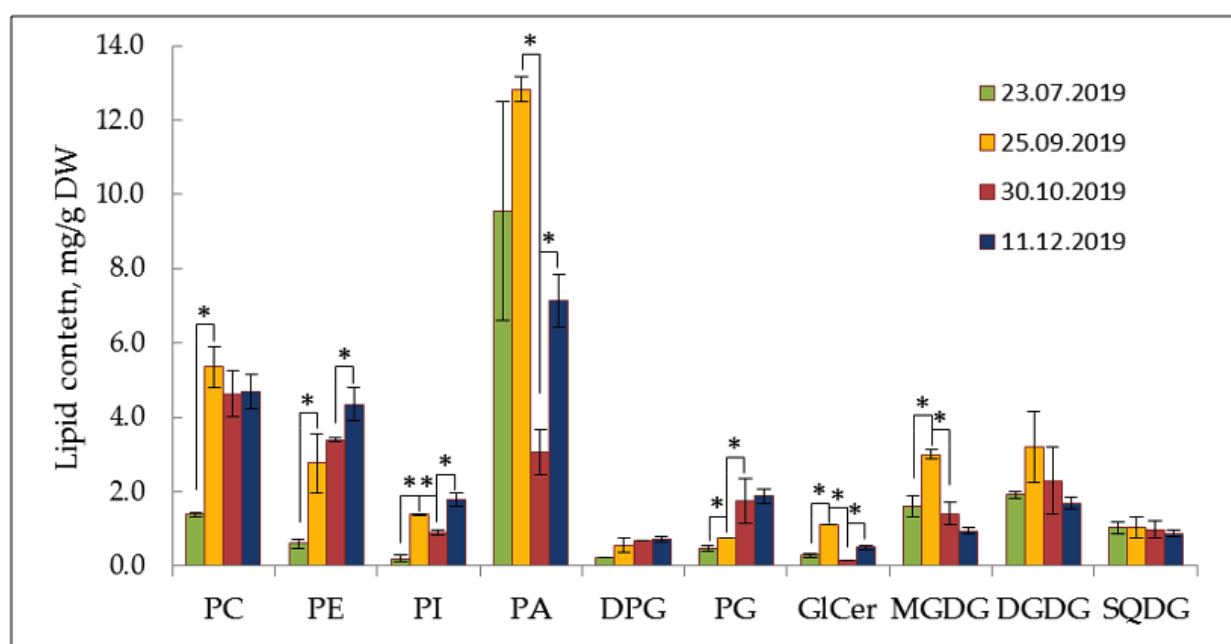
Figure Figure 1. Seasonal content of each class of major membrane lipid in Ephedra monosperma (mg/g DW) . PC — phosphatidylcholine; PI — phosphatidylinositol; PE — phosphatidylethanolamine; PG — phos- phatidylglycerol; PA — phosphatidic acid; DPG — diphosphatidylglycerol; GlCer — glycoceramide, DGDG — digalactosyldiglyceride, MGDG — monogalactosyldiglyceride, SQDG — sulfoquinovo- syldiacylglycerol. Data are shown as the mean ± SD ( n = 3); * significant differences according to Student’s t -test.